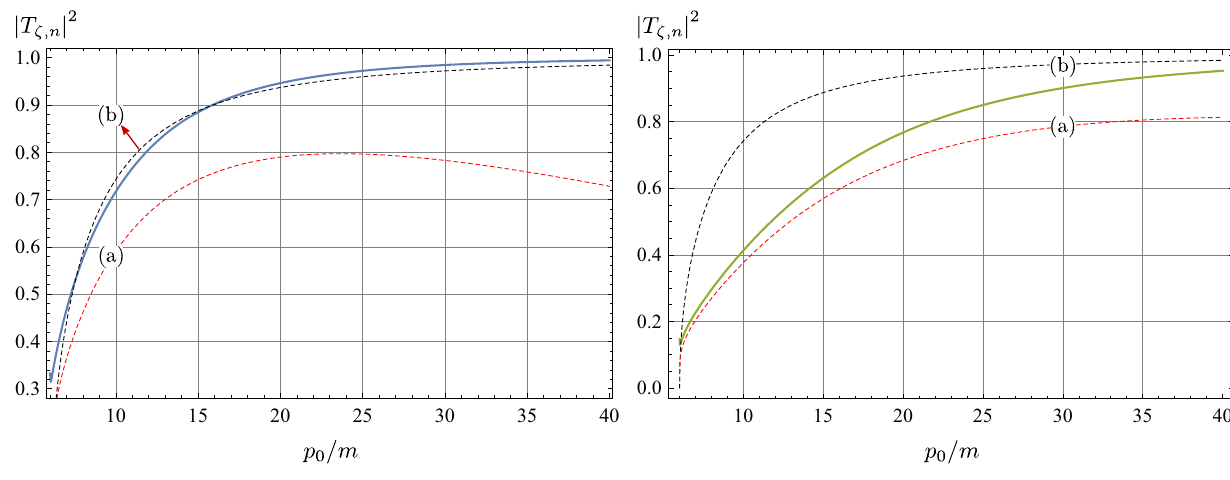
( b ) : approximations given by Eq. (101). In the left panel, E = 250 E and m ξ 1 = m ξ 2 = 1 / 50 while in the right panel, E = 500 E c and m ξ 1 = m ξ 2 = 1 / 100. The lower bound of (cid:19) 1 is the same for both plots which, in this system of units, is p 0 / m = (cid:22) (cid:21) (cid:3)(cid:18) (cid:18) (cid:18) (cid:18) (cid:2) − 1 (cid:18) 2 (cid:18) 2 = (cid:18) T (cid:18) g − 1 + . ζ, n + |